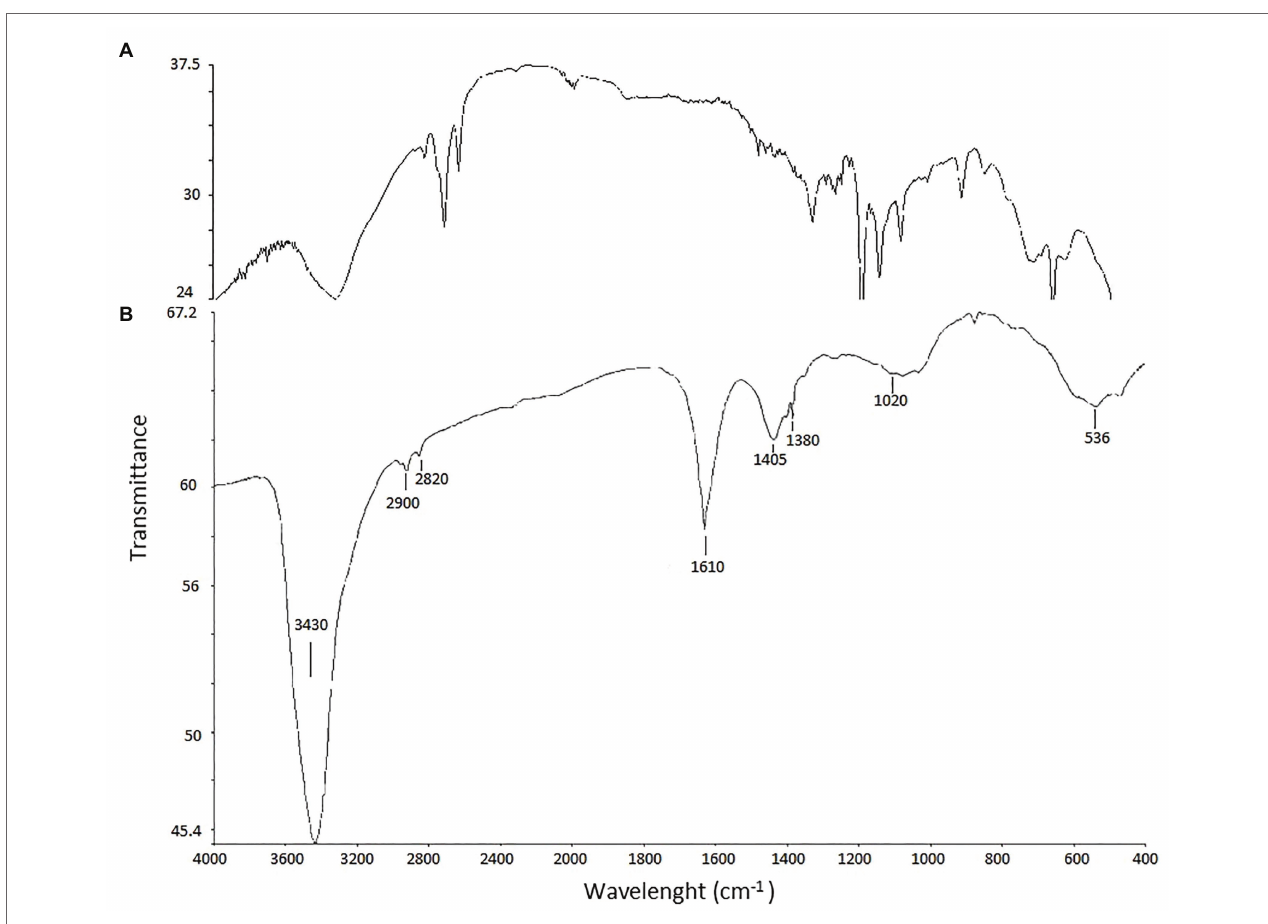
FIGURE 5 | FTIR spectrum of biosynthesized AgNPs. AgNPs (A) and control (B) .